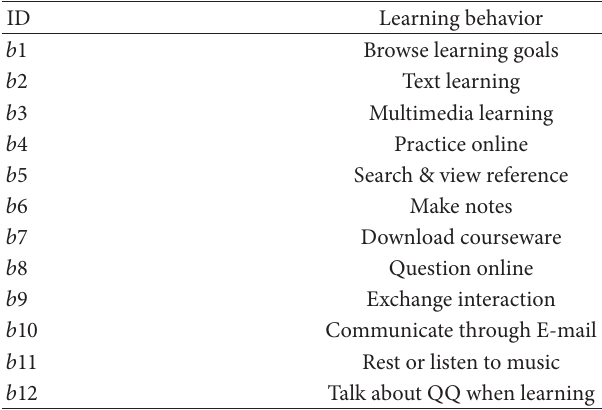
Table 2: Preset 12 kinds of online learning